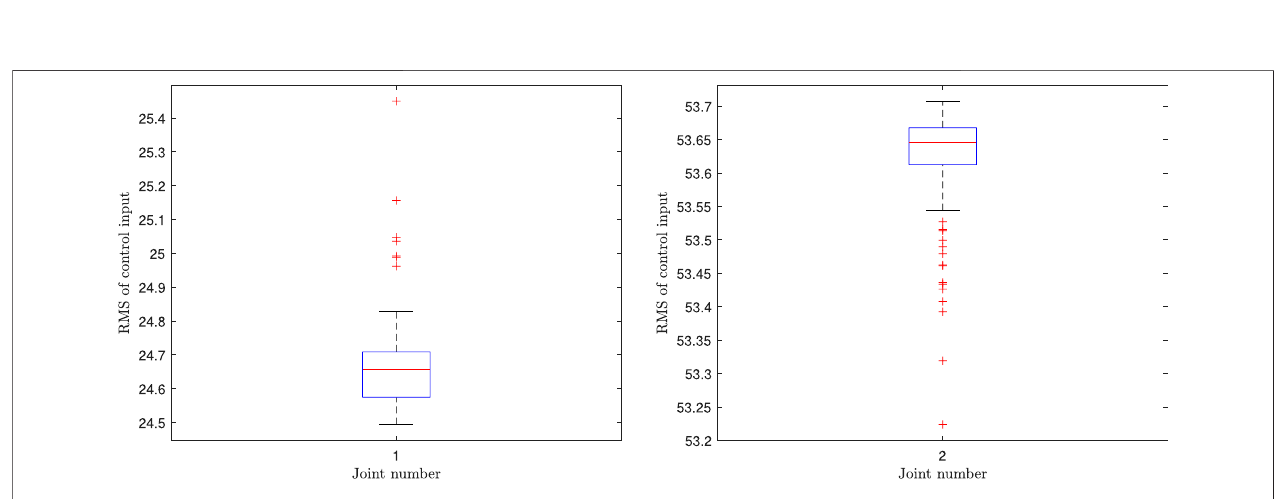
FIGURE 10 | The RMS values of control inputs corresponding to a traditional ProMP controller for the fi rst joint (left) and second joint (right).